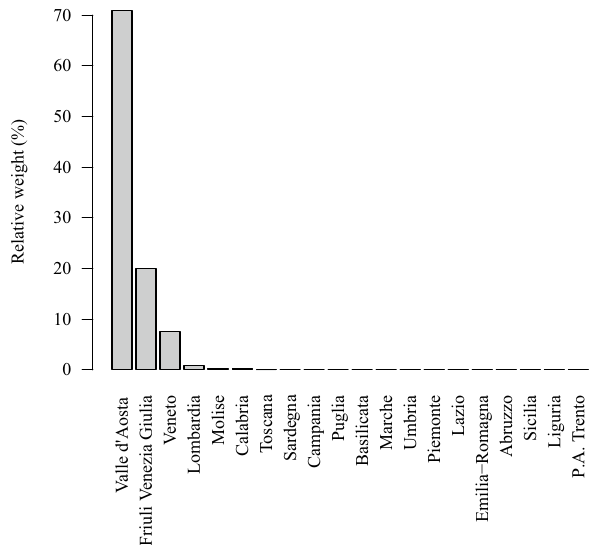
Figure 1. Synthetic control weights used to construct the synthetic control